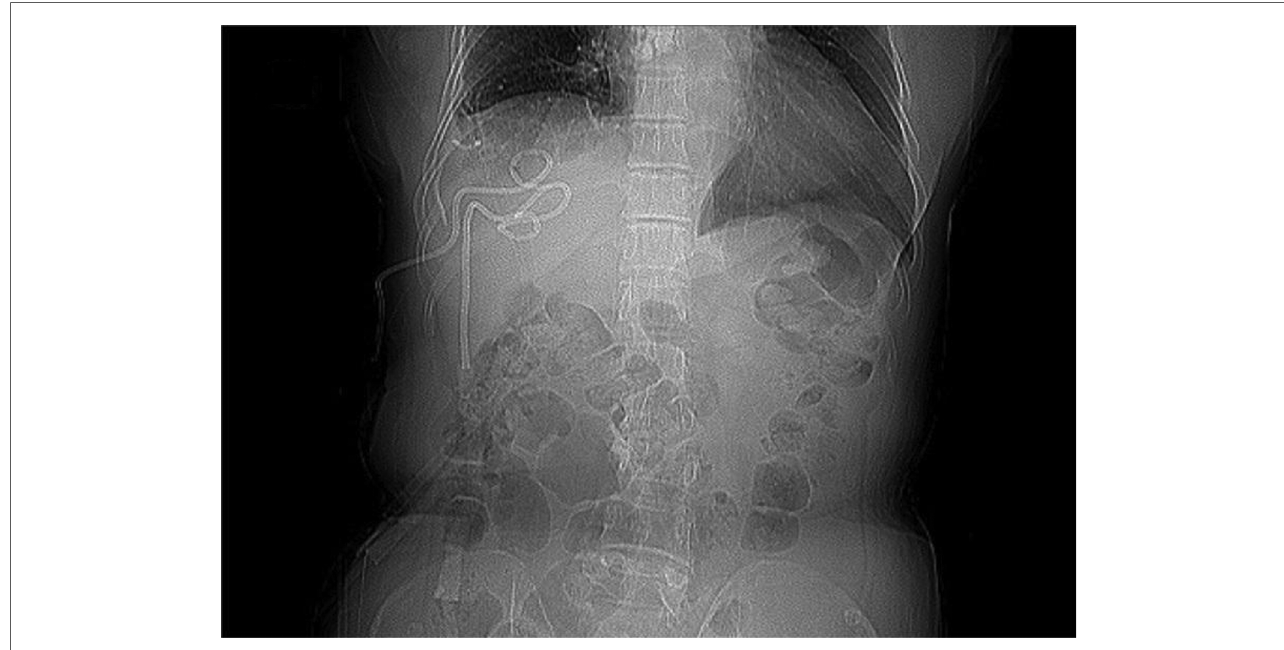
FIGURE 1 Preoperative abdominal CT suggested a large multiloculated pyogenic liver